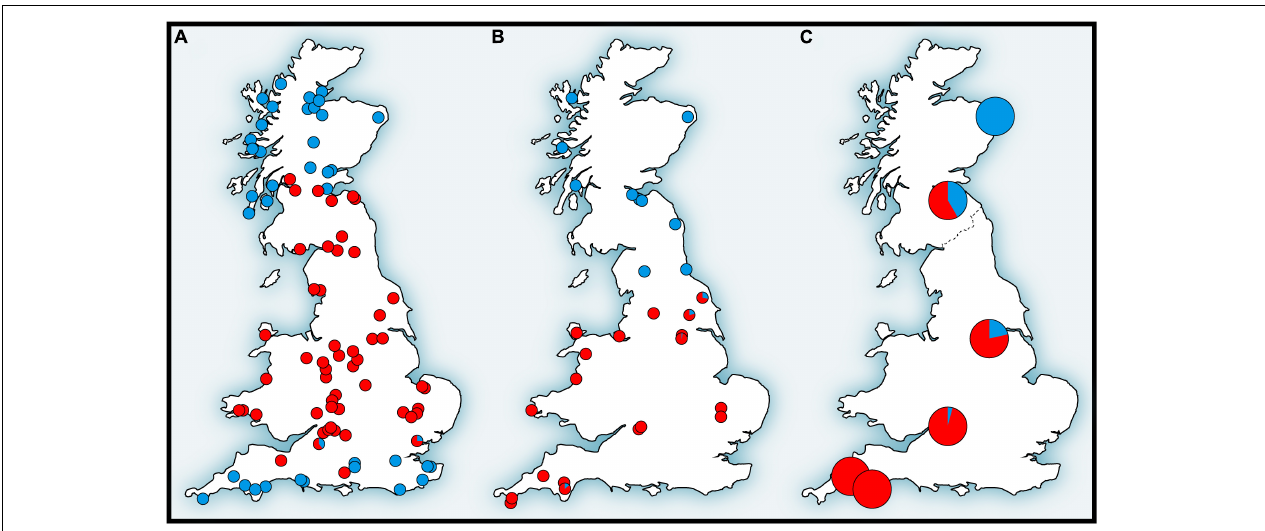
FIGURE 4 | Distribution patterns of (A) mitochondrial DNA, (B) hemoglobin, and (C) single nucleotide polymorphism (SNP) variations of the bank vole in Britain that form the genetic "Celtic fringe" (for details, see text) (adapted from Kotlík et al., 2018).